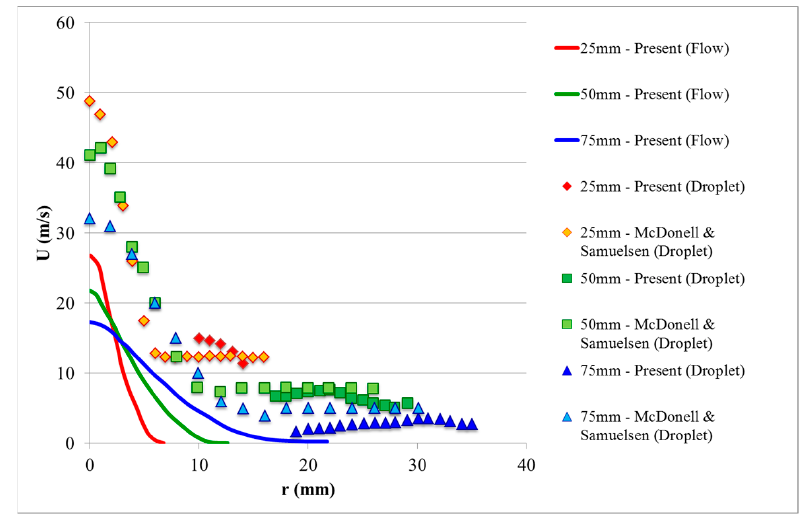
Figure 15. Axial velocity of droplets at axial distances of 25, 50, and 75 mm with non-swirling atomizing air.